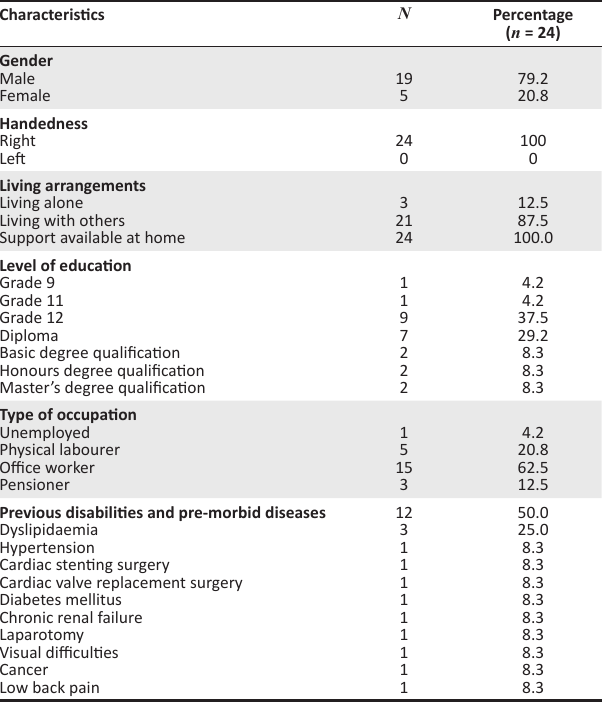
TABLE 2: Baseline characteristics and demographics for study participants.